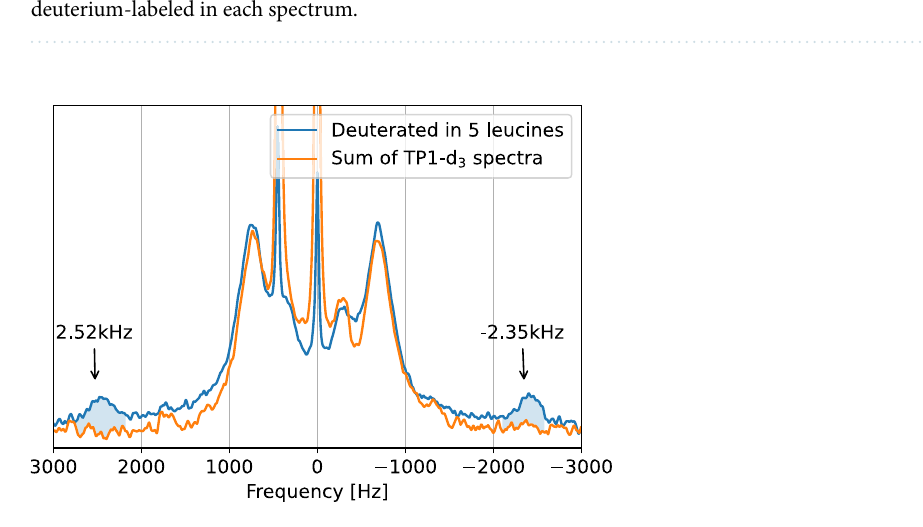
2 Figure 3. Sum of H-NMR spectra of membrane-embedded TP1 with deuterium labels in the residues Leu-4, 2 Leu-5, Leu-7 and Leu-8 separately, shown in orange. H-NMR spectrum of membrane-embedded TP1 with deuterium labels in all five leucine residues simultaneously, shown in